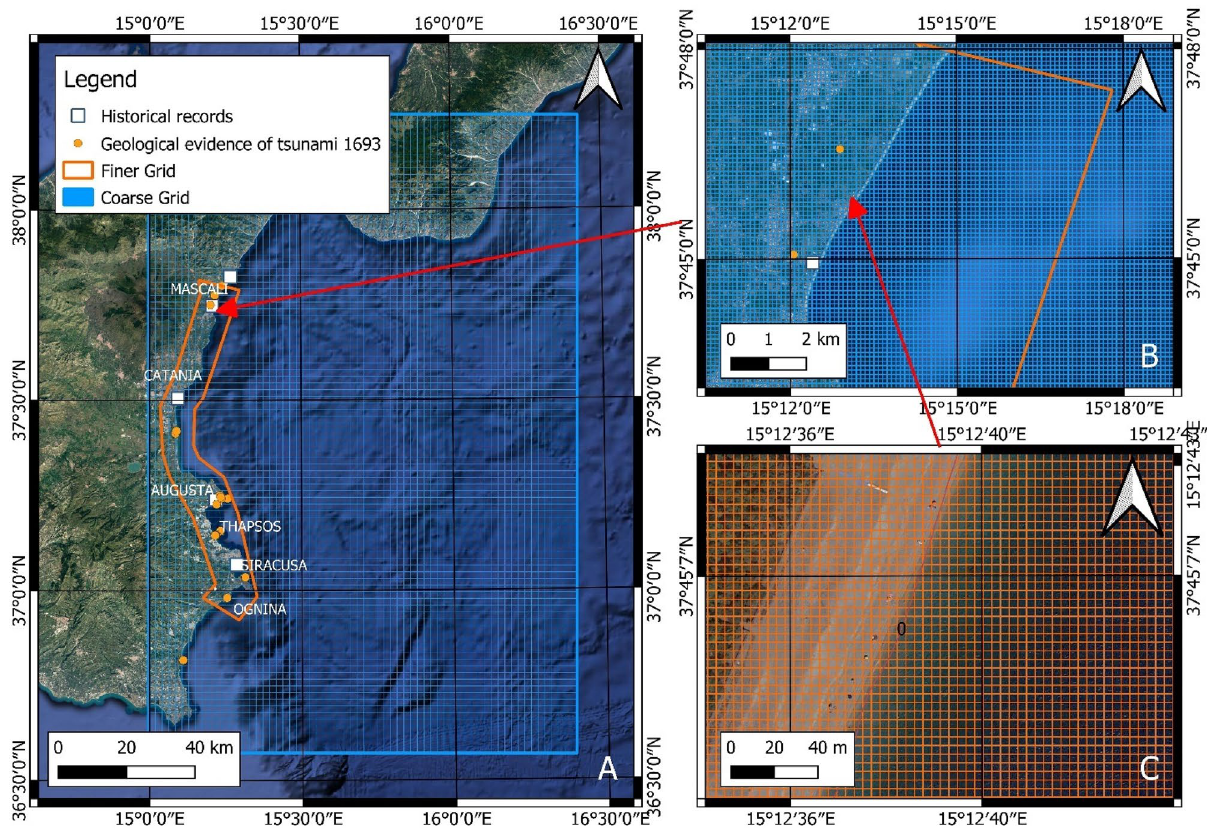
Figure 16. Resolution of the grids used for the simulation of tsunami events: ( A )—extension of the coarse (blue rectangle) and finer (orange area) grids in eastern Sicily; ( B )—cell resolution of the coarse grid in the Mascali area; ( C )—cell resolution of the finer grid in the Mascali area. The maps were obtained by co-authors through QGIS—software (version 3.14.16); https:// www. qgis. org/ it/ site/, license Creative Commons. Attribution-Share Alike 3.0 licence (CC BY-SA) integrated with ESRI World